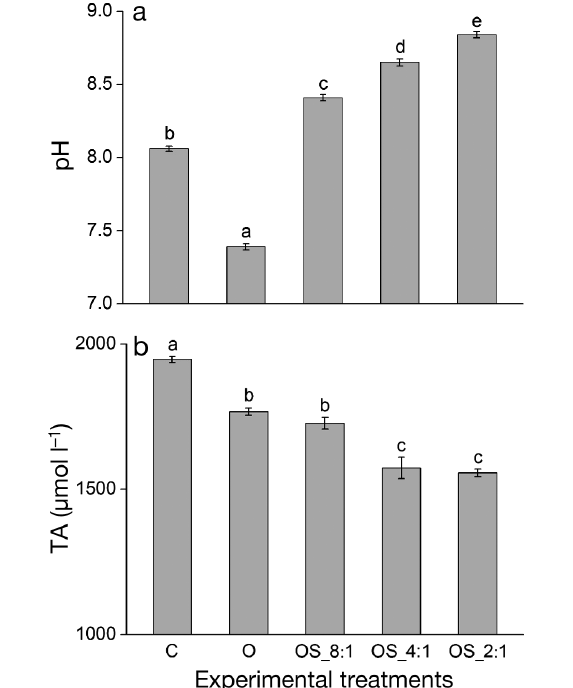
Fig. 4 (a) Seawater pH and (b) total alkalinity (TA) of oyster Crassostrea angulata monoculture and oyster−seaweed Gracilaria lemaneiformis co-culture mesocosms. C: control; O: oyster only; OS_8:1, OS_4:1, and OS_2:1: oyster co- cultured with seaweed at ratios of 8:1, 4:1, and 2:1, respec- tively. Bars with different lowercase letters are significantly different (ANOVA, p <